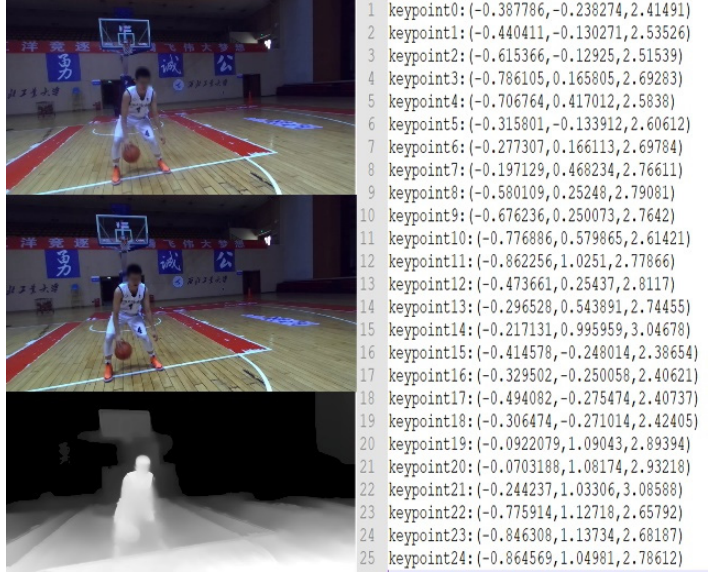
Figure 4. An example of NPU RGB+D dataset modalities. Starting from the upper left corner are a left view, right view, depth map, and skeleton joint point coordinate data map.